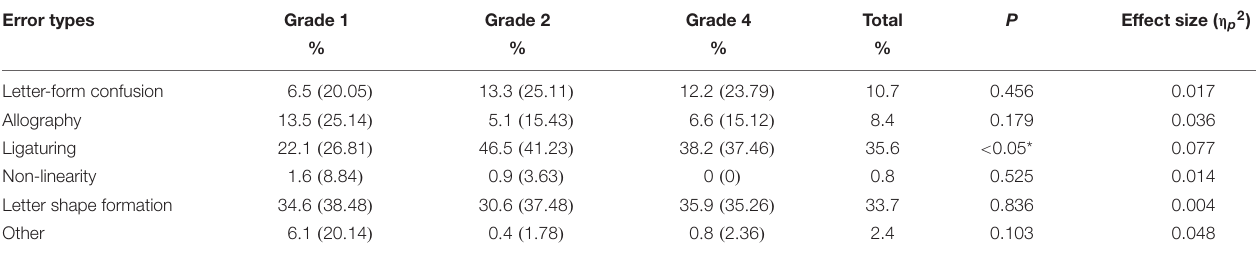
TABLE 4 | Means (in percentages) and standard deviations (in parentheses) of error rates for the separate visual-orthographic categories across three grade